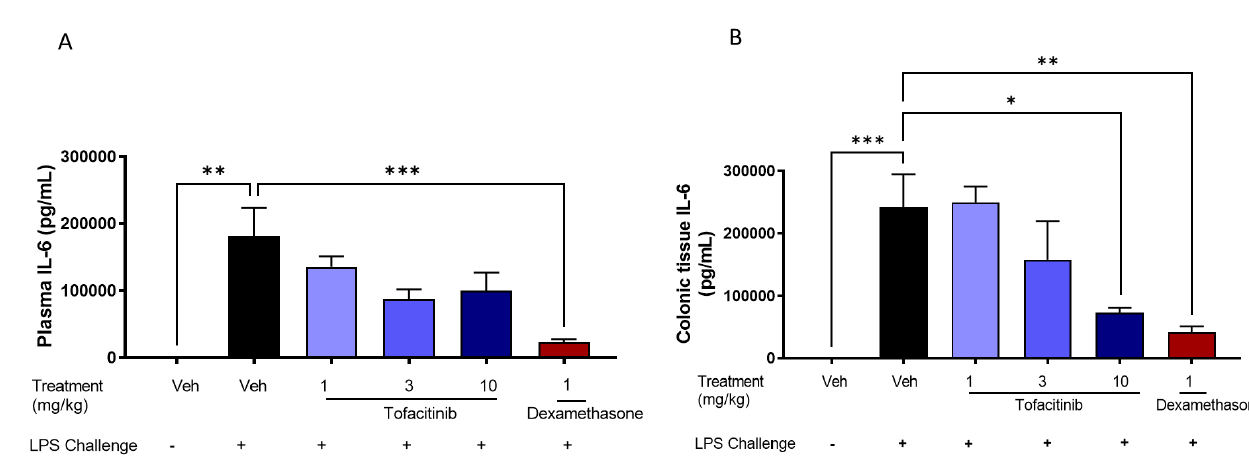
Figure 5. Plasma ( A ) and colonic tissue ( B ) levels of interleukin 6 (IL-6) in rats with LPS-induced inflammation 8 h after administration of Phloral ® -coated tofacitinib capsules at 1, 3, and 10 mg/kg (3 h after LPS treatment). Controls included naïve rats (no LPS, treatment with phosphate buffered saline (PBS)); LPS + vehicle (LPS administration, treatment with PBS); and LPS + 1 mg/kg dexamethasone solution. n = 8 per treatment group.